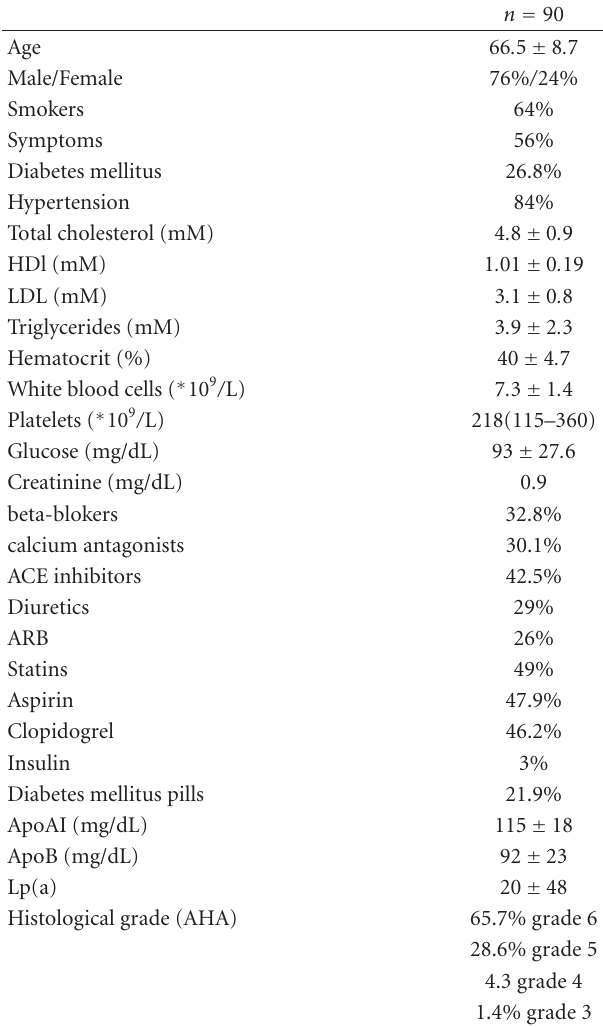
Table 1: Patient